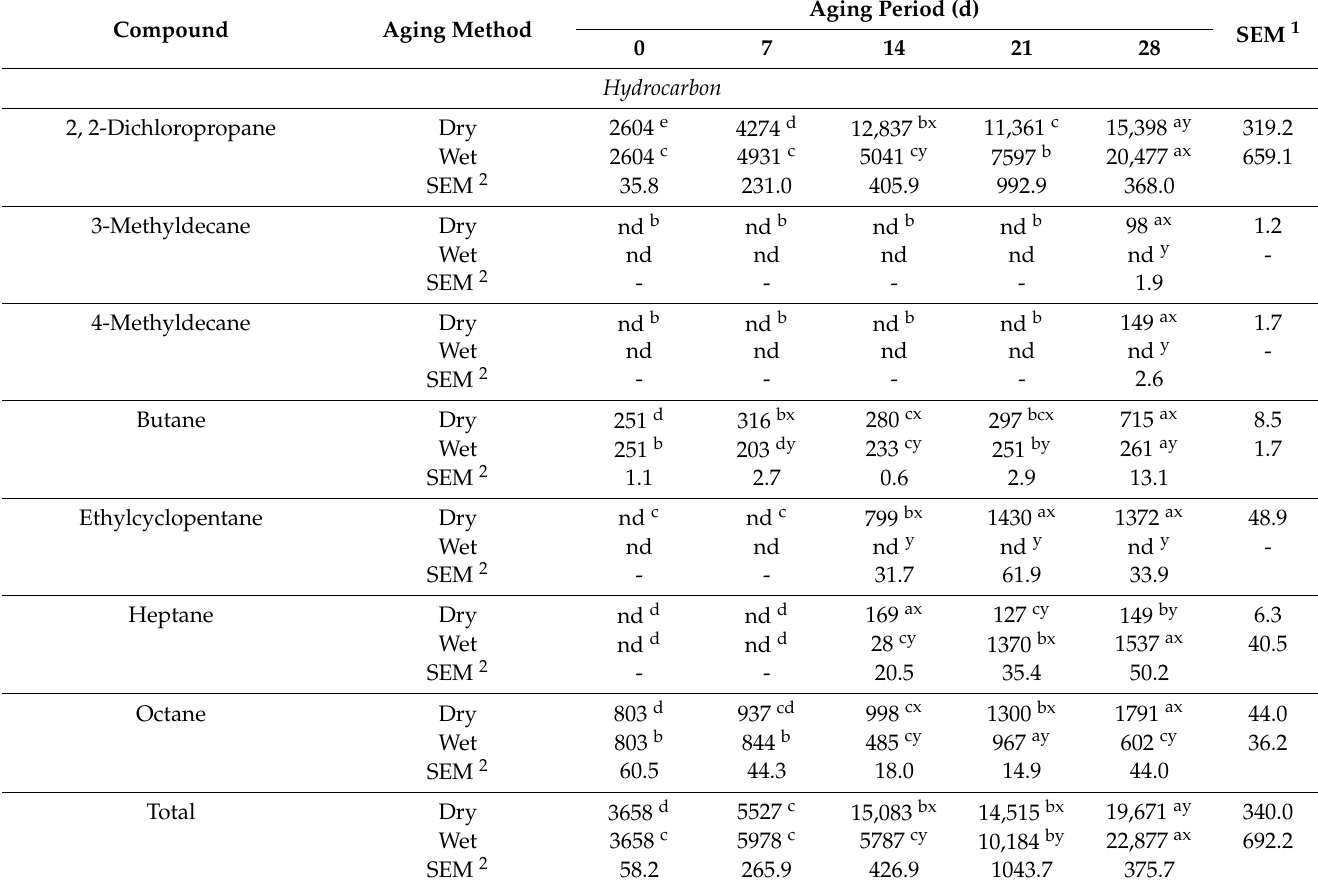
Table 7. Peak area of hydrocarbons, esters, and acids in beef during aging with different aging methods. Compound Aging Method